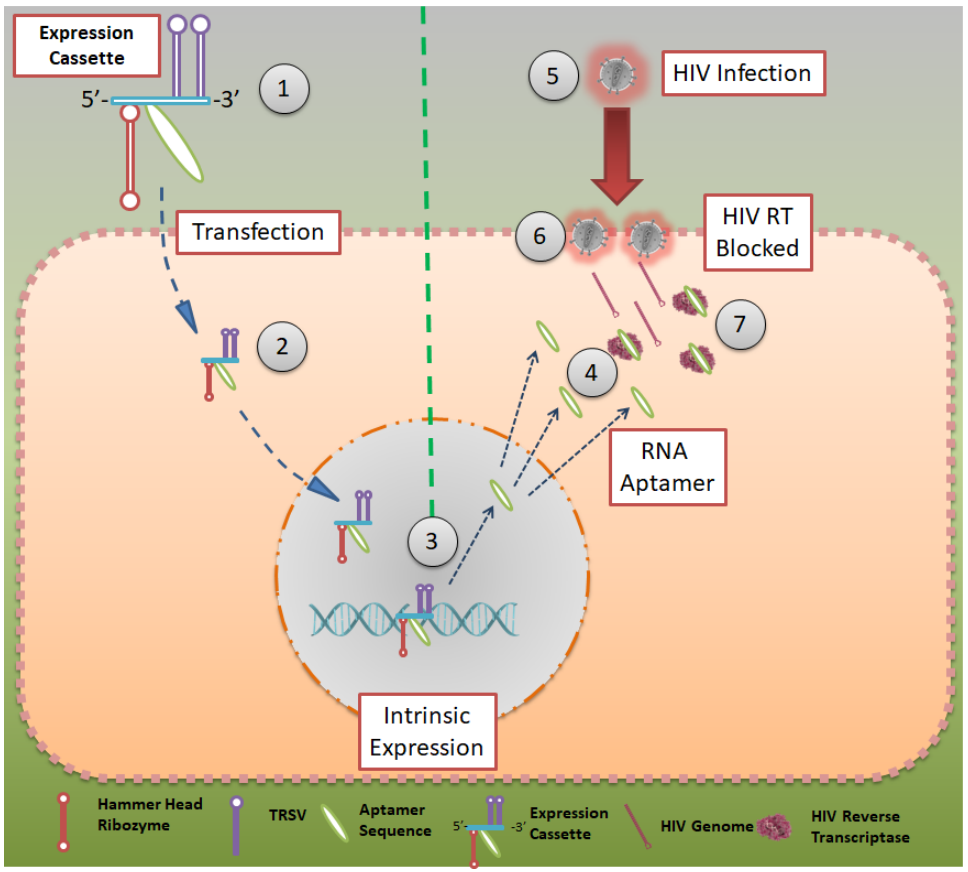
Figure 3. Aptamer expression cassette: Expression cassette modeled after HIV-RT that can be produced in intracellularly modified cells. Hammerhead ribozymes that are tertiary stabilized with self-cleavage activity may be expressed in infected cells. CC BY 4.0 license